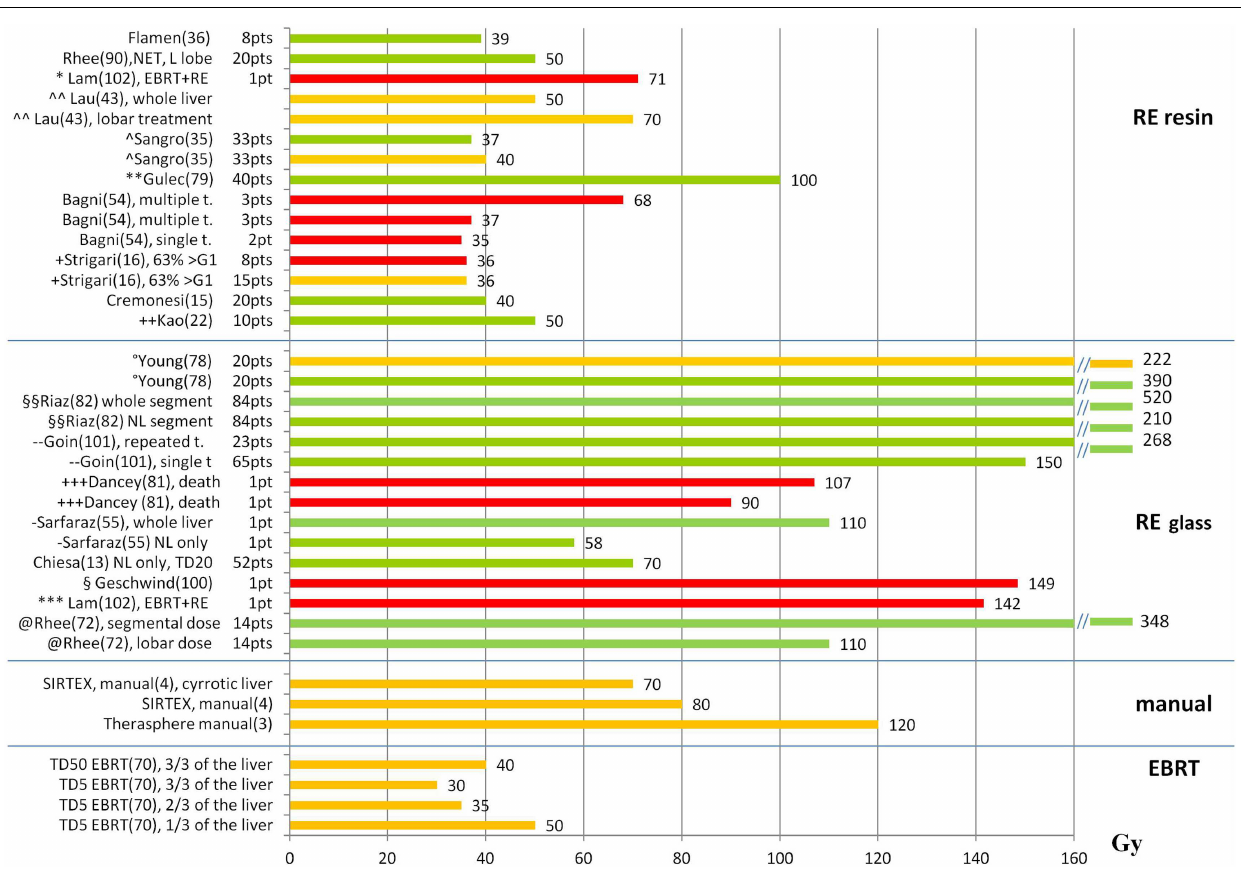
FIGURE 1 | Liver absorbed doses (Gy) and tolerability .The graph shows the liver absorbed doses (Gy) reported in the literature with information about the associated liver tolerability. Red bars represent liver toxicity with fatal event (death); orange bars represent the threshold for observed toxicity or the limit recommended by the author; green bars represent tolerated absorbed doses. References are reported in parenthesis after the name of the first author. t., treatment; *(77) patient with previous EBRT (21Gy) and RE with 71Gy, ∧∧ (42) recommendation based on a review of the literature, ∧ (59) primary + mets,WL treatment, **(78) primary + mets,WL treatment, + (16) HCC,WL (48%) and L (52%), mean dose toWL for REILD > G1: 6–78Gy.The